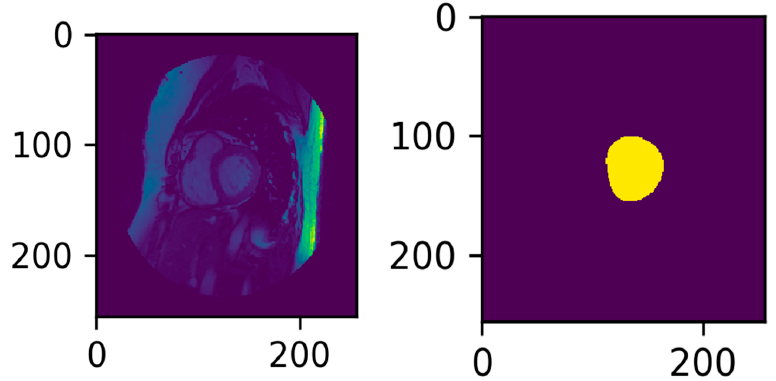
Figure 7. A sample image from the dataset and its generated